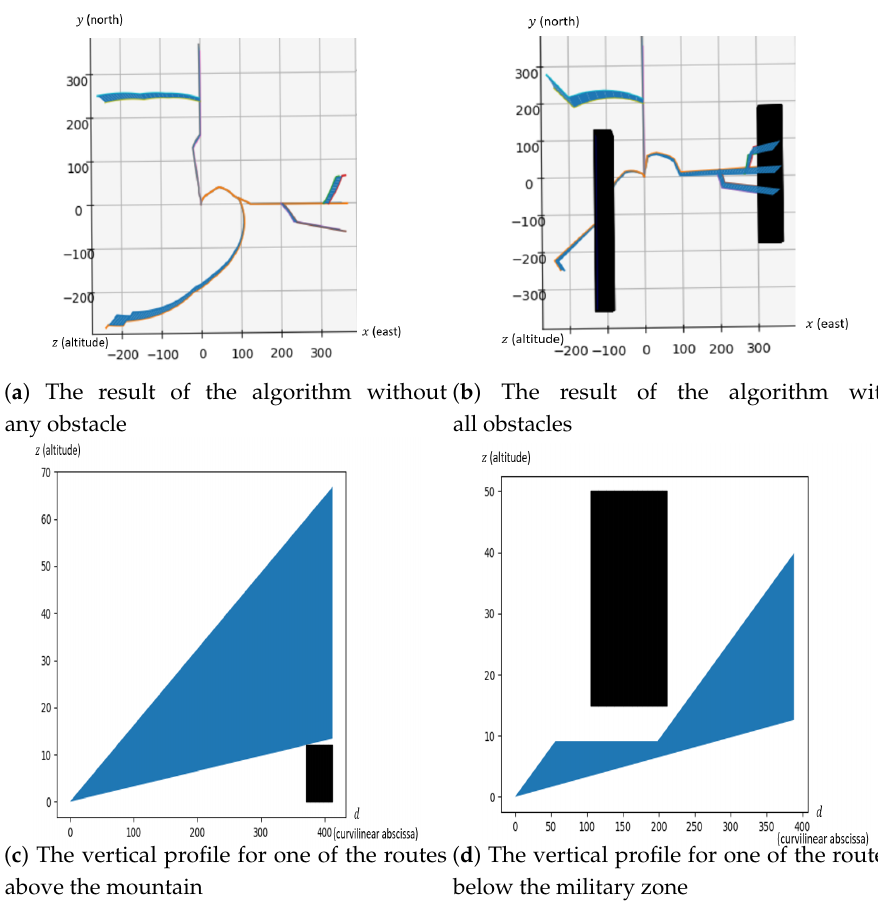
Figure 14. The result of the algorithm with all obstacles at